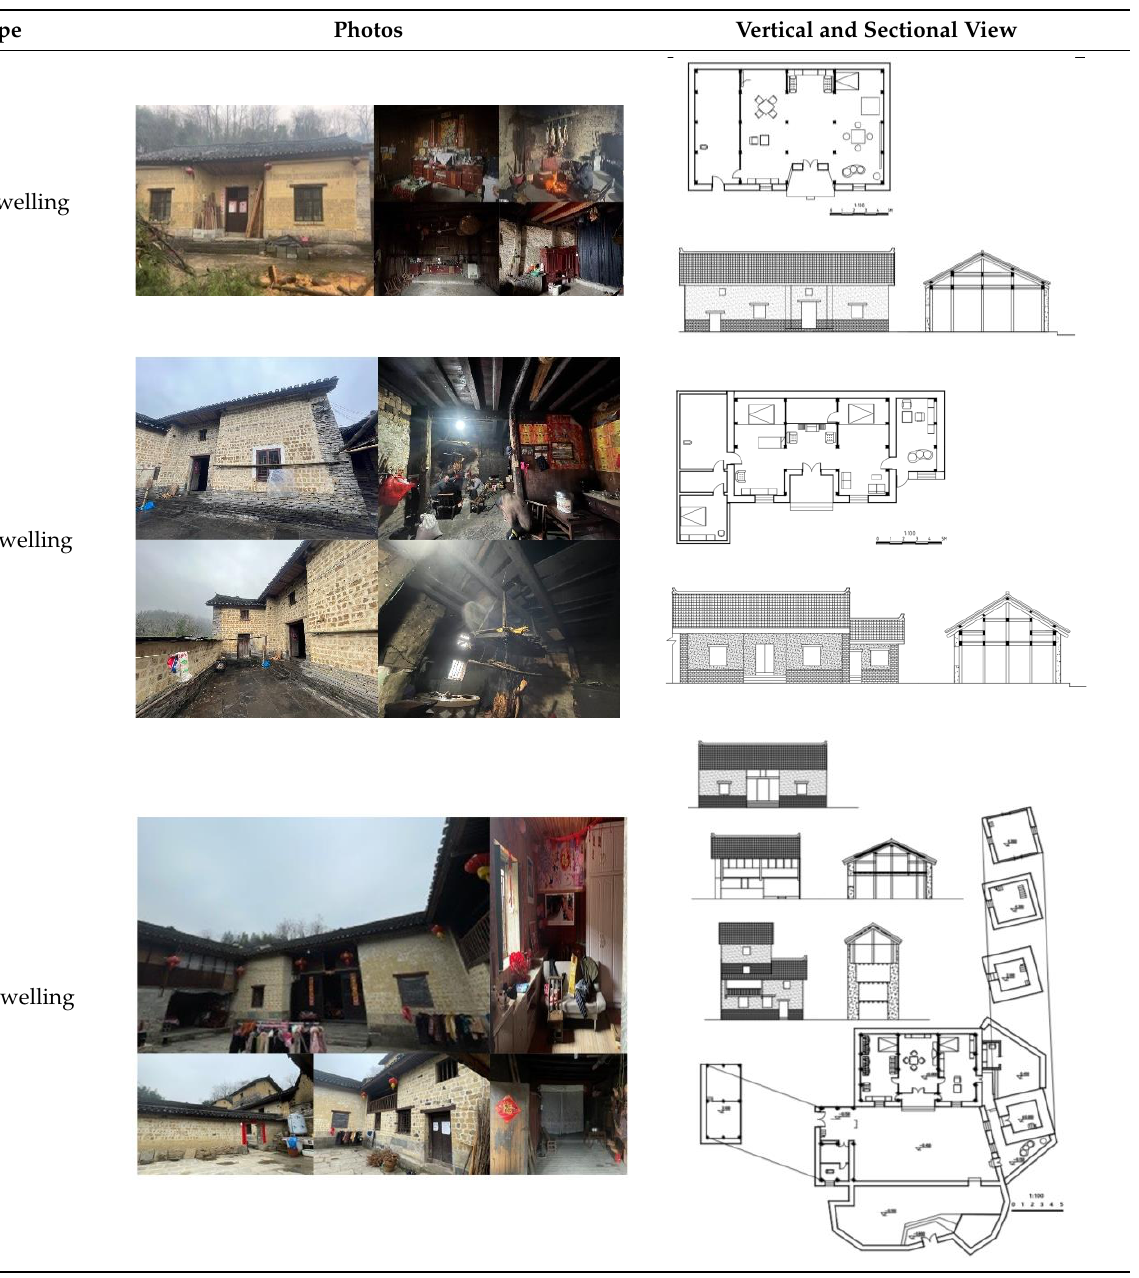
Table 3. Typical floor plan type of traditional vernacular dwelling in Zhushan Village.